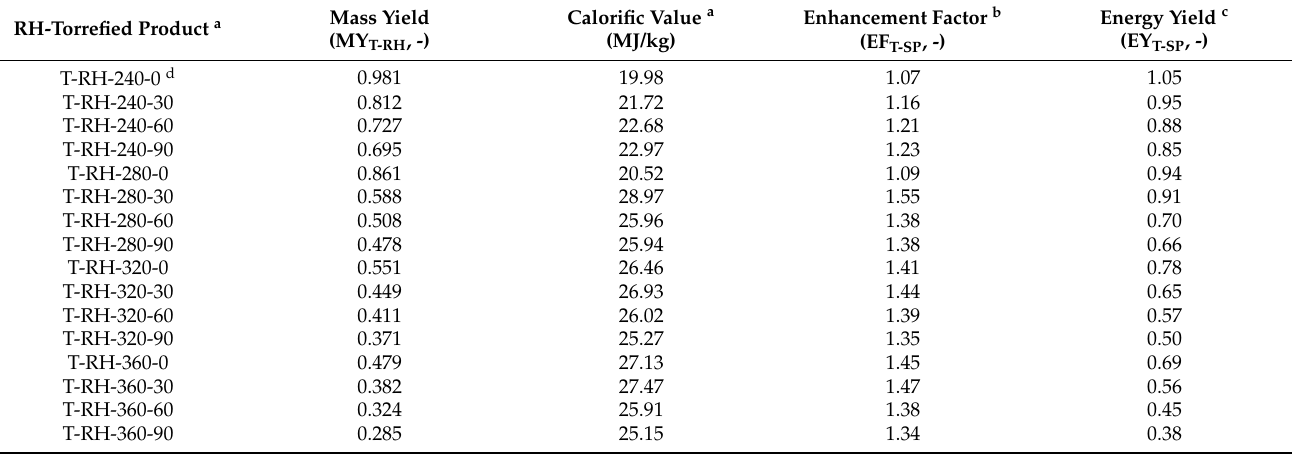
Table 1. Mass yields and calorific values of torrefied products (T-RH) produced from pretreated rice husk (RH-25) at different torrefaction temperatures (240–360 ◦ C) and holding times (0–90 min). Mass Yield Calorific Value a Energy Yield c Enhancement Factor b RH-Torrefied Product a (MY T-RH , -) (MJ/kg) (EY T-SP , -) (EF T-SP , -) T-RH-240-0 d